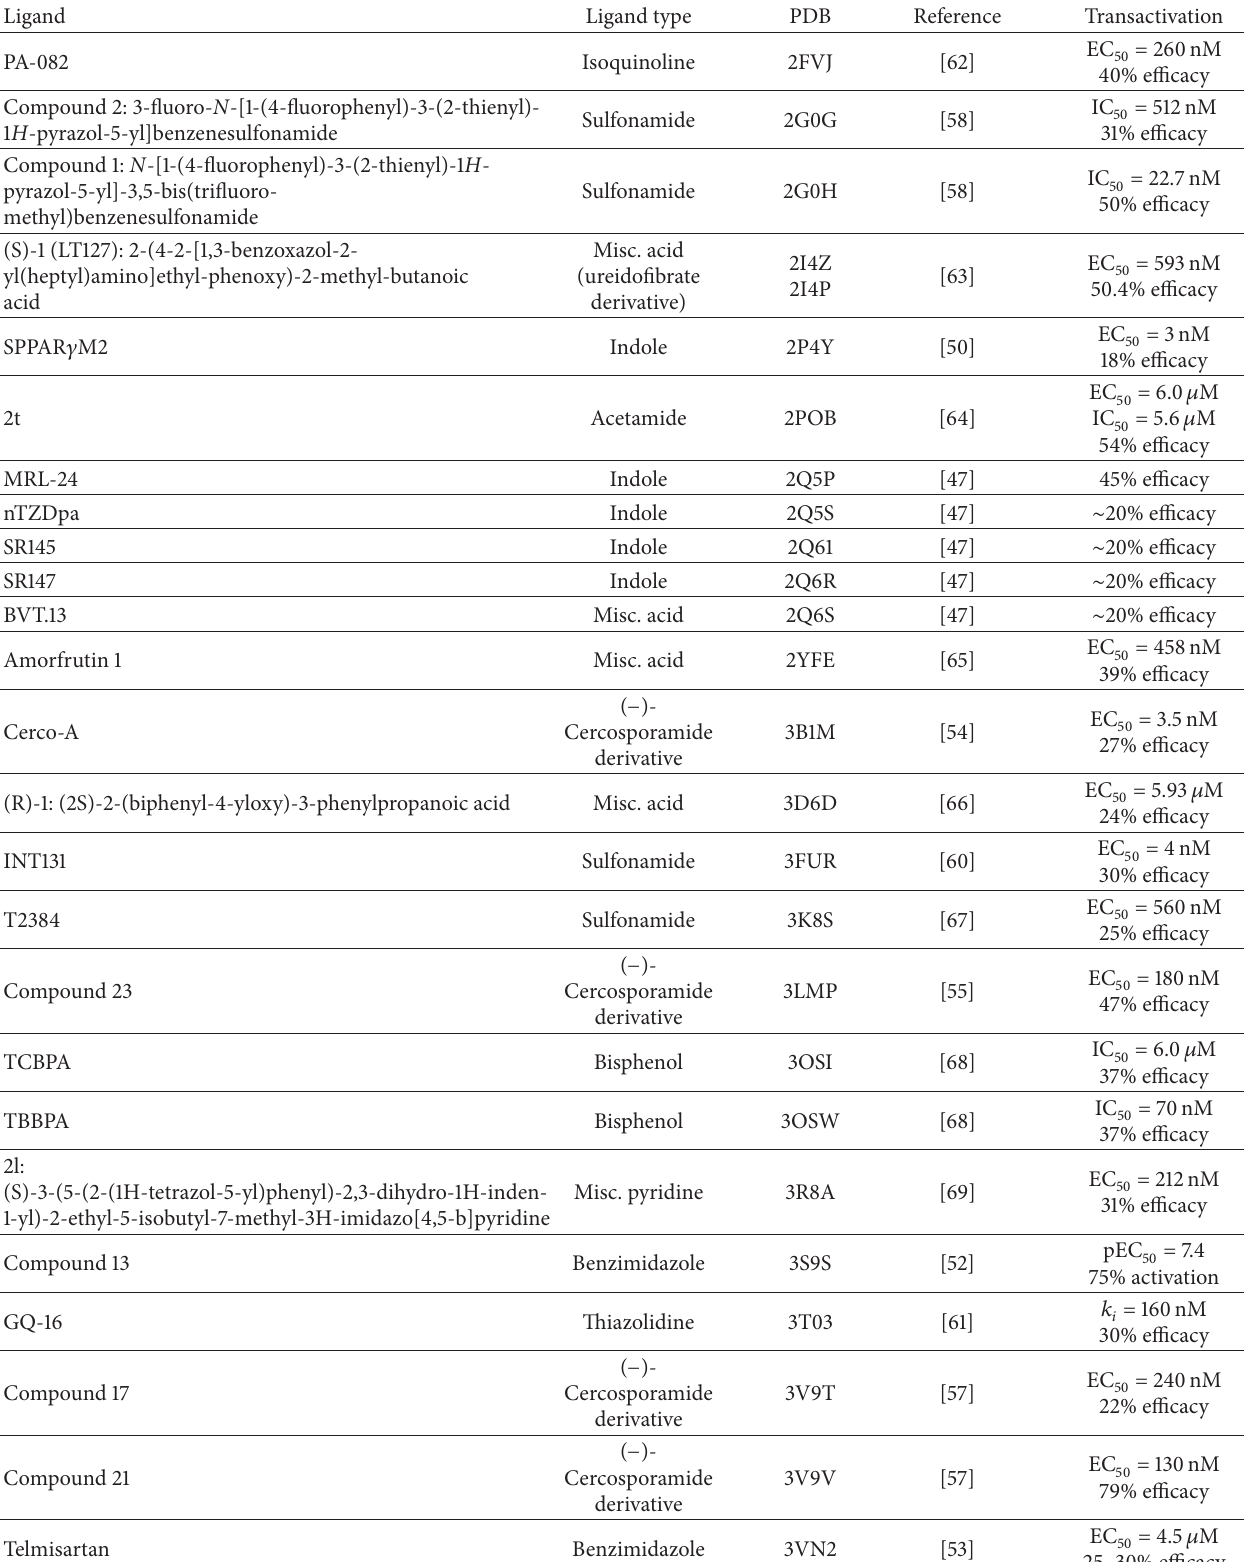
Table 2: Crystal structures of PPAR 𝛾 partial